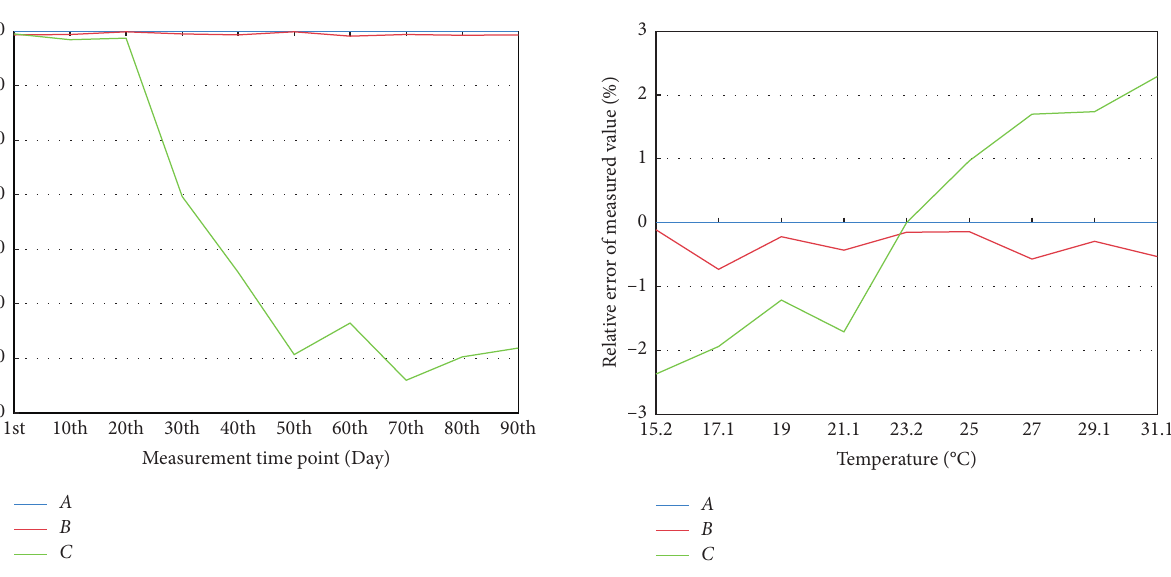
Figure 10: Relative errors with A of old and new temperature compensation